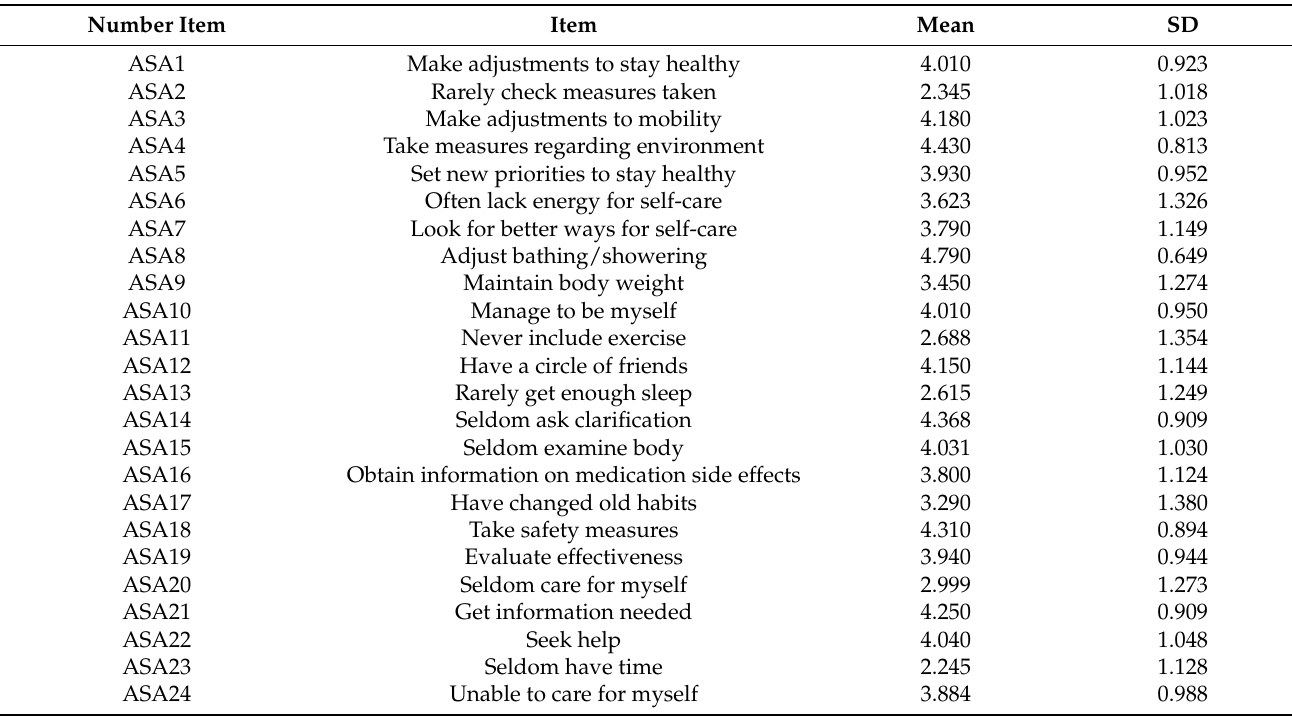
Table 1. Item descriptive mean scores of the ASA scale.